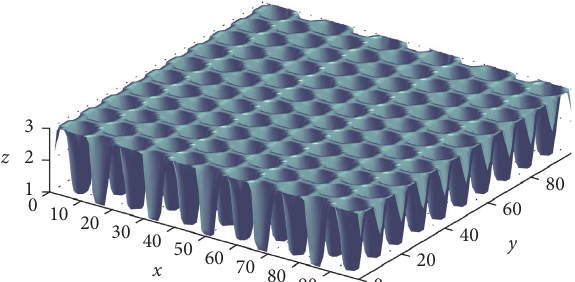
Figure 1: No magnetic photonic crystal slab structure with average dielectric permittivity, where dielectric slab ( ε holes ( ε h � 3 ) ordered periodically.